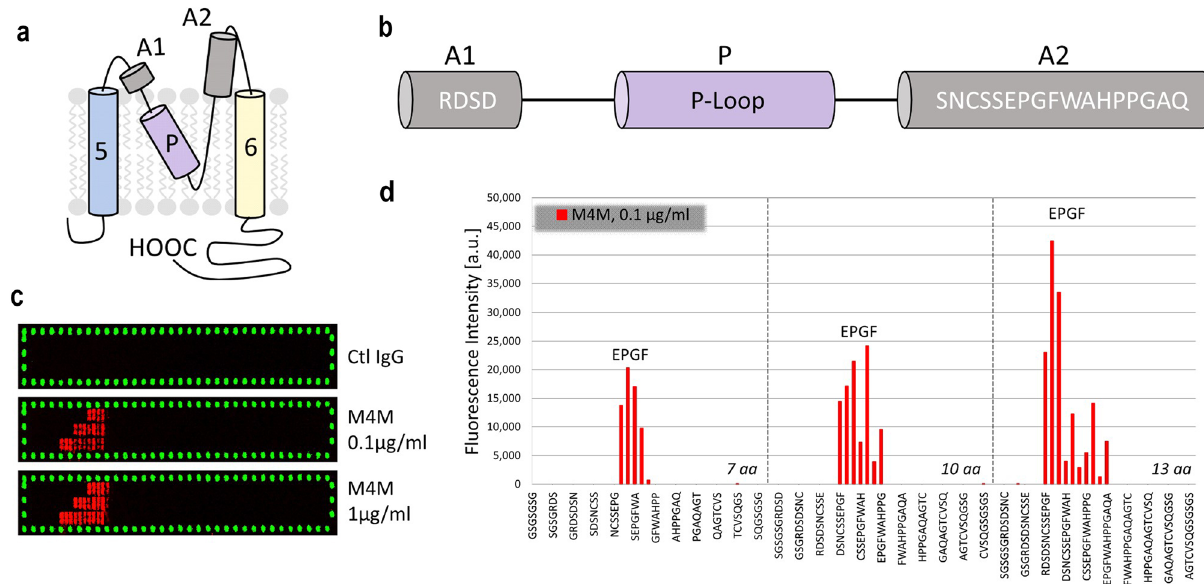
Figure 1. Identification of binding epitope for M4M. ( a ) Schematic representation of the transmembrane segments 5 and 6 of the human TRPM4 channel. Antigenic epitope for M4P is labelled as A1 and A2. P: pore-loop. ( b ) Amino acid sequence of A1 and A2, separated by channel pore (p-loop). ( c ) Read-outs of a conformational peptide microarray incubated with control mouse IgG of 1 µg/ml or M4M at a concentration of 0.1 and 1 µg/ml, followed by staining with the secondary antibodies (red: sample staining; green: control staining). For each read-out picture, top row: 7 amino-acid fragments; middle row: 10 amino-acid fragments; bottom row: 13 amino-acid fragments. ( d ) At peptide lengths of 7, 10, and 13 amino acids, a very strong antibody response against epitope-like spot patterns formed by adjacent peptides with the consensus motif